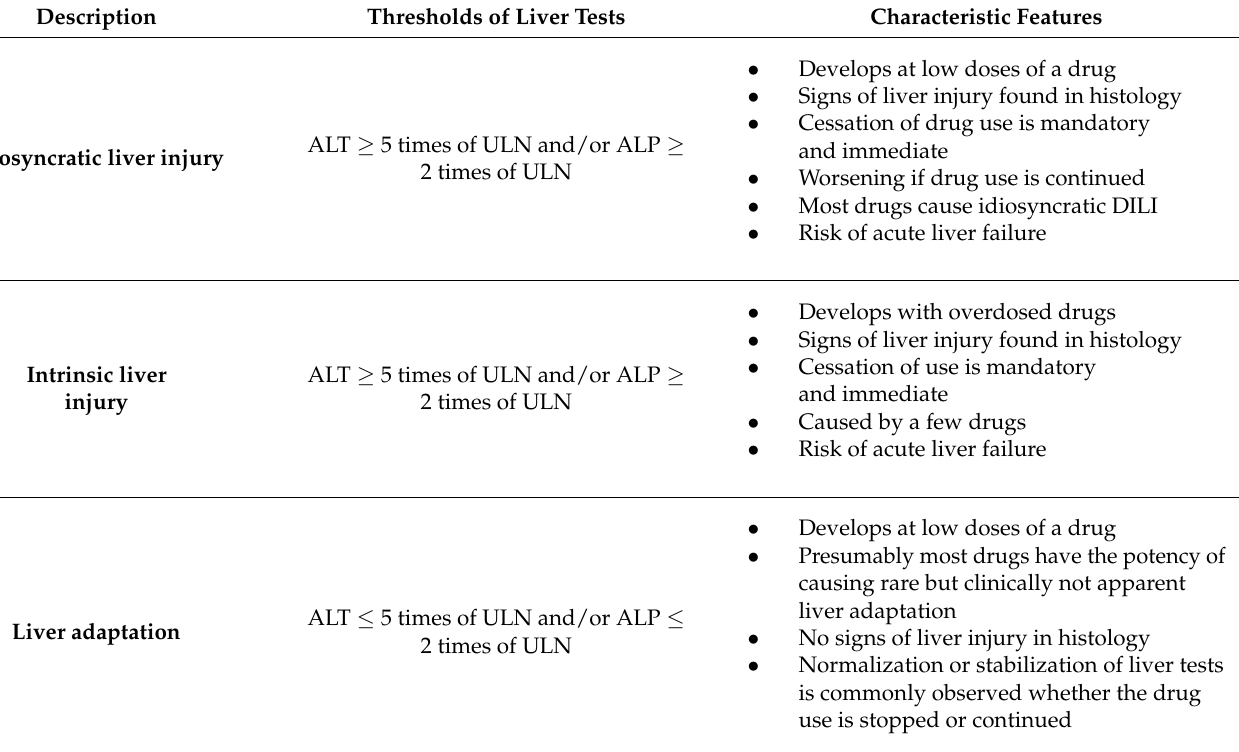
Table 2. Thresholds of serum ALT and ALP activities in patients with liver injury and liver